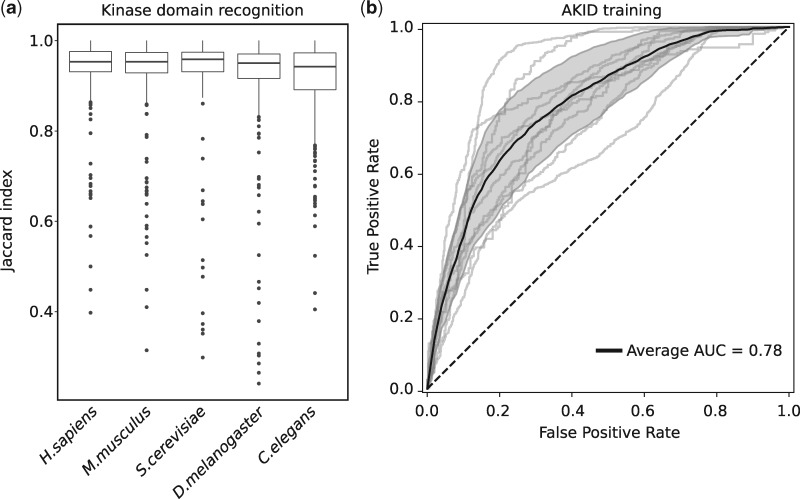
Detection of kinase domains in eukaryotes and training of AKID. a: Distribution of Jaccard indexes representing the overlap between the identified (via HMM) and annotated kinase domains in different eukaryotic organisms. b: Training of AKID through a 10-fold cross-validation. The 10 ROC curves are represented with light gray lines (summed up by a light gray area representing the 95% confidence interval), a black line represents the average performance of the method during the training. A dashed black line represents random predictions (AUC of 0.5)